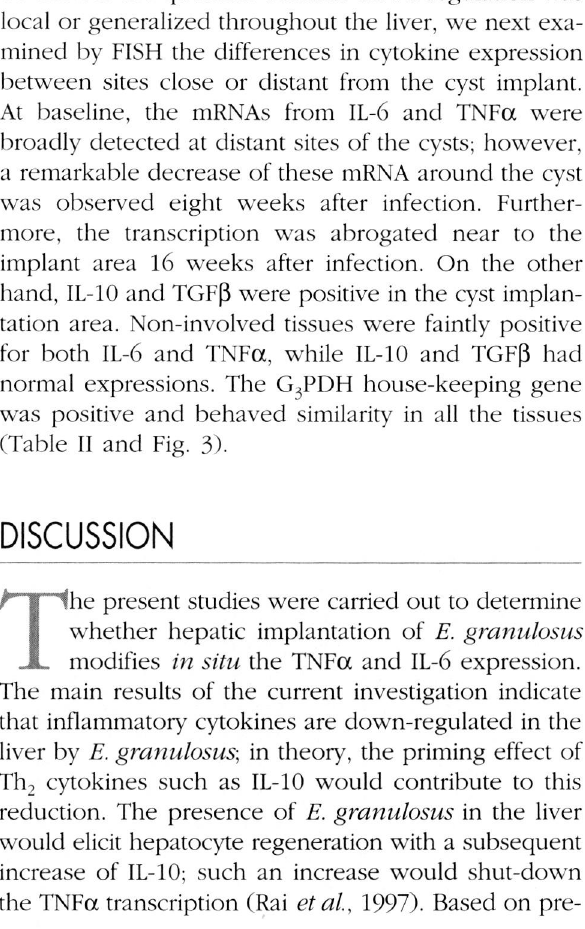
Table I. - Cytokine expression in liver by RT-PCR.